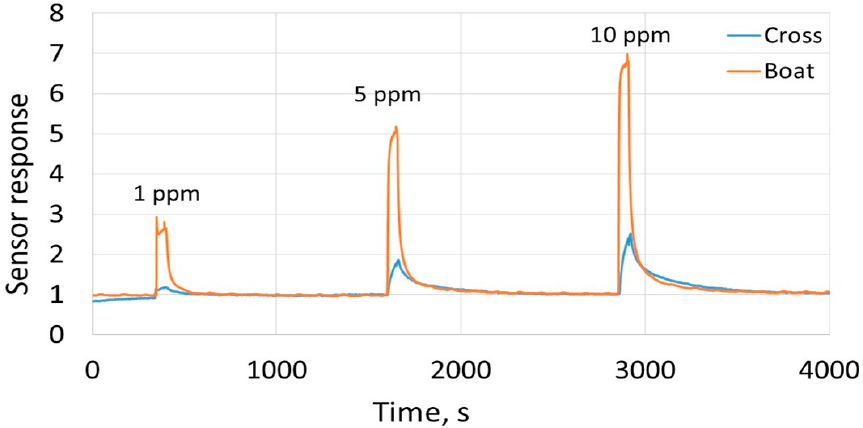
Figure 3. Sensor responses toward different concentrations of